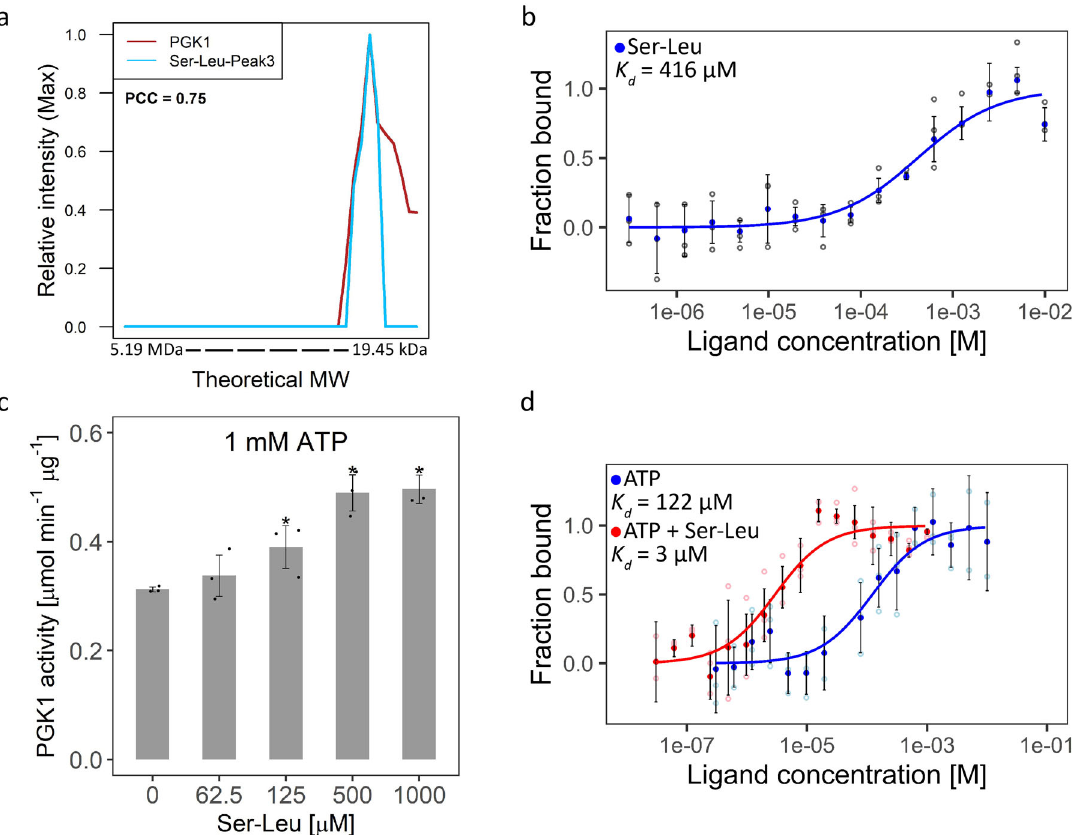
Fig. 5 Characterisation of the Pgk1 – Ser-Leu interaction. a The elution pro fi le of Pgk1 and its putative ligand Ser-Leu (Supplementary Data S6 and S7). The intensity was calculated relative to the maximum intensity of the molecule measured across size exclusion chromatography fractions. The theoretical molecular weight (MW) was estimated using reference proteins. The Pearson correlation coef fi cient (PCC) indicates a correlation coef fi cient calculated between depicted elution pro fi les. b Microscale thermophoresis analysis of Pgk1 and Ser-Leu binding (Supplementary Data S26). K d indicates dissociation constant. Data represent the means ± SD, n = 3 independent samples. c Functional validation of the interaction between Ser-Leu and Pgk1 (Supplementary Data S28). Ser-Leu signi fi cantly increases Pgk1 activity. Data represent the means ± SD, n = 3 independent samples. Asterisks denote signi fi cant difference (non-paired, two-tailed t test P value < 0.05). d Microscale thermophoresis analysis of Pgk1 and ATP binding in the presence of saturating concentrations (4 mM) of Ser-Leu (Supplementary Data S27). K d indicates dissociation constant. Data represent the means ± SD, n = 3 independent